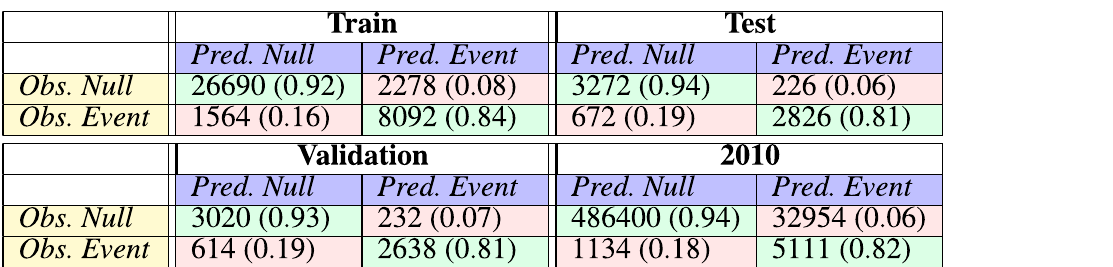
Figure 5 : 90 input nodes with a dropout of 0.3 connected by a recti fi ed linear units (relu) activation function to 40 fi rst hidden layer nodes, which are in turn connected with a dropout of 0.3 and a relu